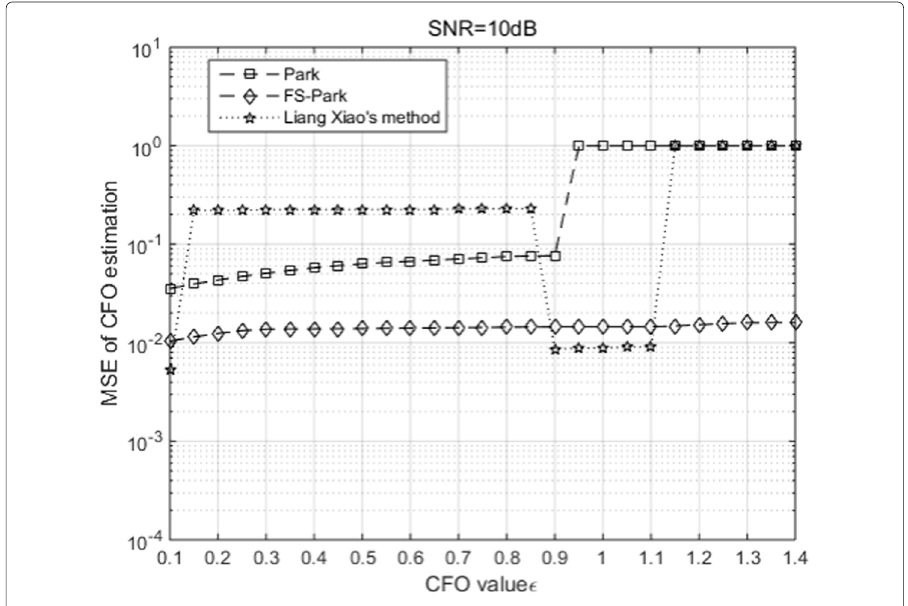
Fig. 12 MSE curves with different